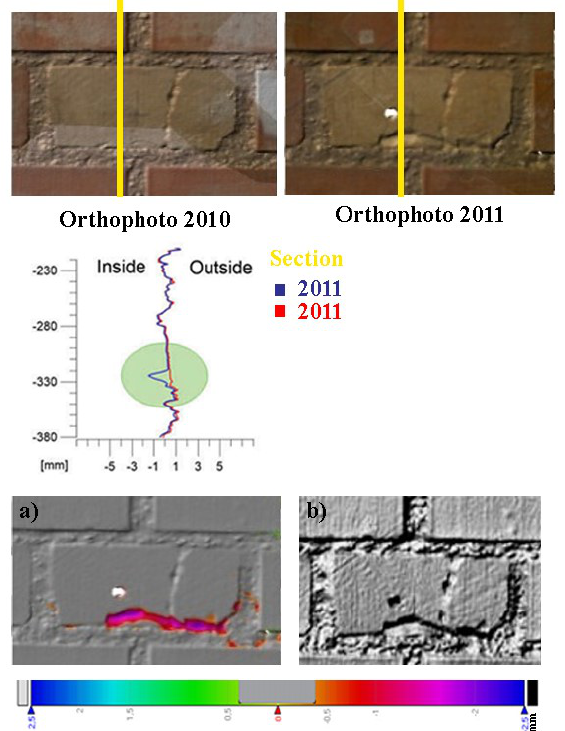
Figure 9. Examples of products derived by triangulation laser data useful for the analysis of wall degradation. From the top: orthophotos and profiles of 2010 and 2011 obtained sectioning the 3D models along the direction drawn in yellow. Images below: a) displacement map [mm]; b) shaded relief map of the 2011 surface, with applied a 7.5 × depth magnification factor (modified by Bitelli et al., 2015).